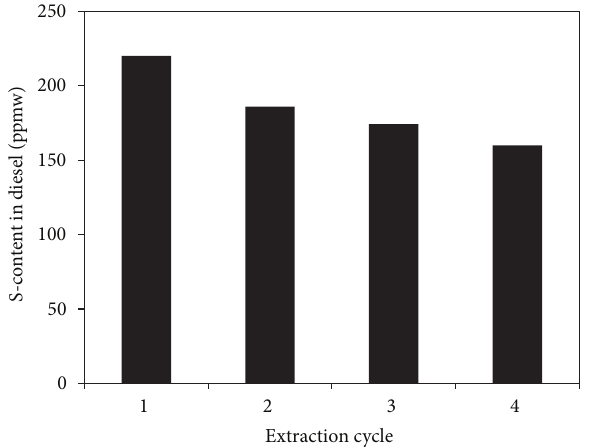
Figure 10: The multistage extraction performance of [BMIM]Cl for diesel (temperature = 30 ∘ C, mass ratio of diesel/IL = 5: 1, extraction time = 30 min, initial sulfur concentration = 385 ppmw).